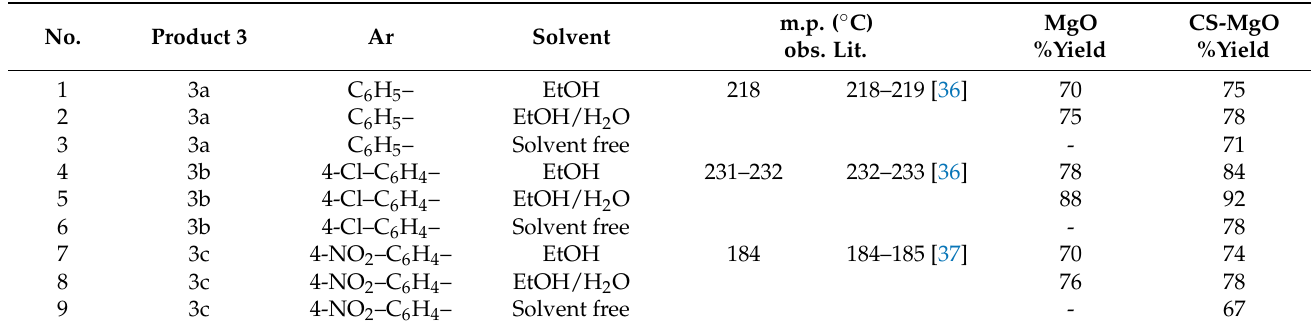
Table 3. Data comparing catalysts and solvents for one pot reactions forming f 2-amino-4-aryl-4H-benzo[h]chromene-3- carbonitrile (Scheme